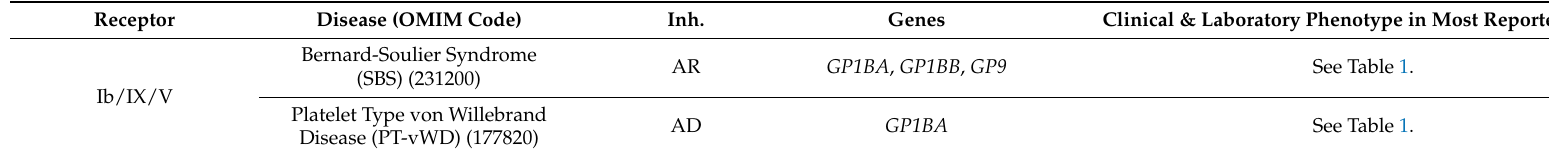
Table 2. Inherited defects of platelet